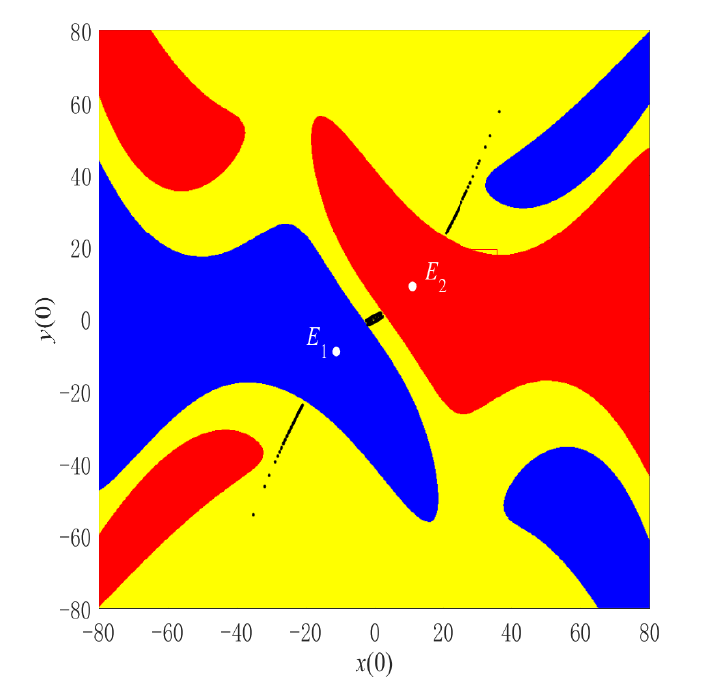
Figure 3. ( a ) 3D phase portrait of system (1) for ( a , b , c , k ) = ( 10,100,11.2, − 0.2 ) . Initial conditions I 1 lead to hidden chaotic attractor, and initial conditions I 2 , I 3 lead to asymptotically converging behaviors to equilibrium point E 1 and E 2 , respectively; ( b ) coexisting time series diagram of x ( t ) .